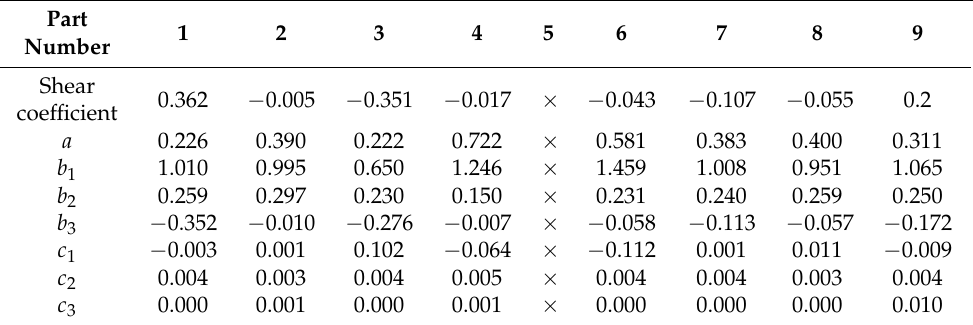
Table 3. Shear coefficient and undetermined coefficients of the response surface function at the second stage.